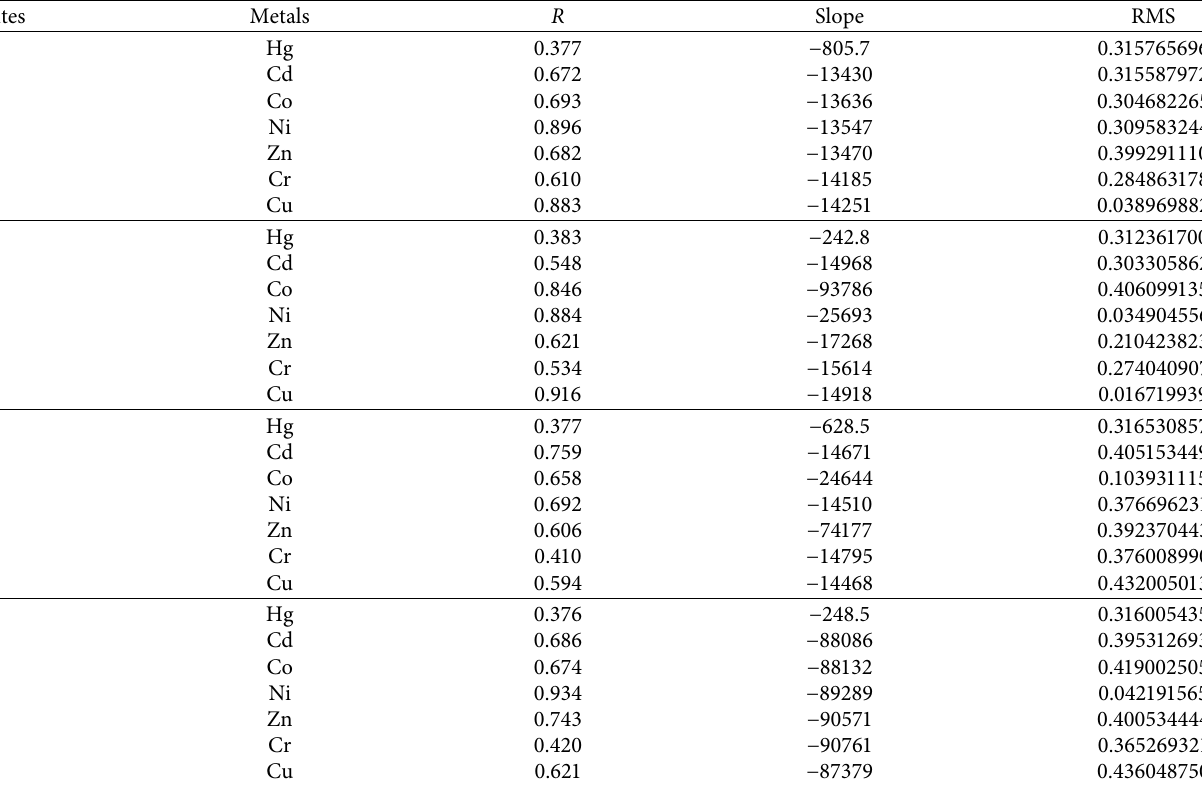
Table 1: Correlation coefcient ( R ), slope, and residual mean square (RMS) values were obtained for the exponential decay model for hospital wastewater at diferent concentrations of metals.